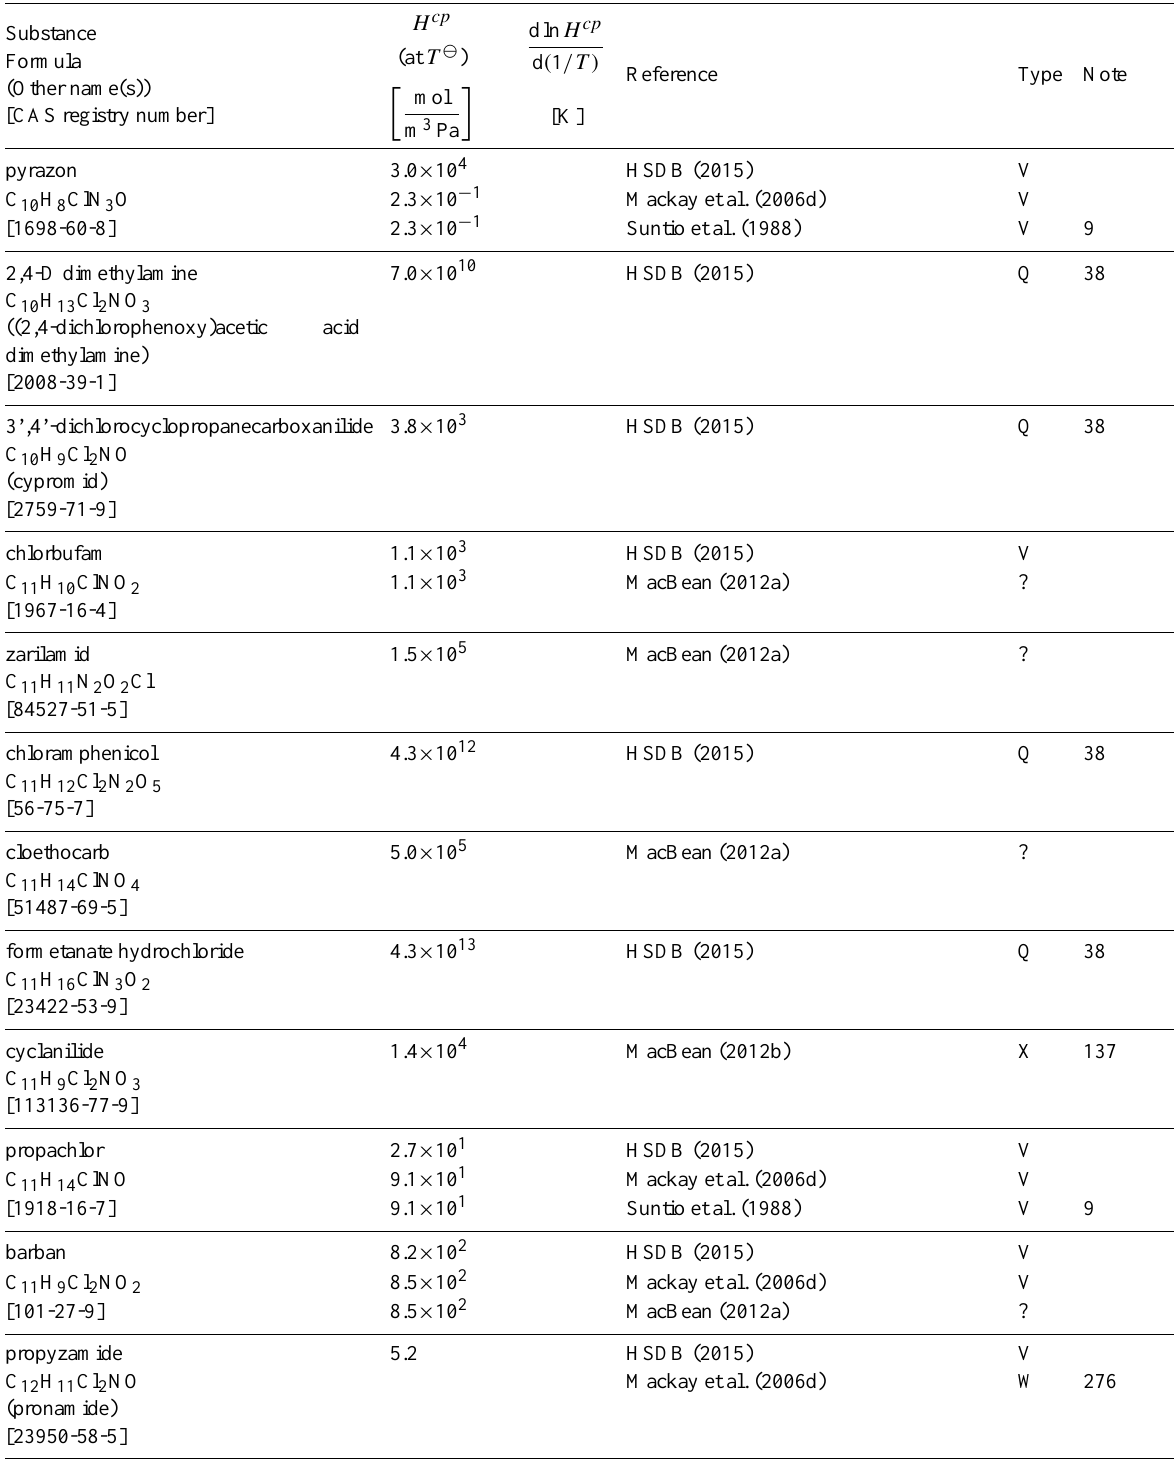
Table 6: Henry’s law constants for water as solvent